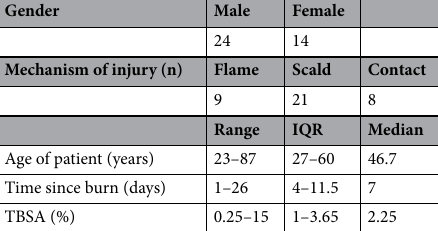
Gender Male Female 24